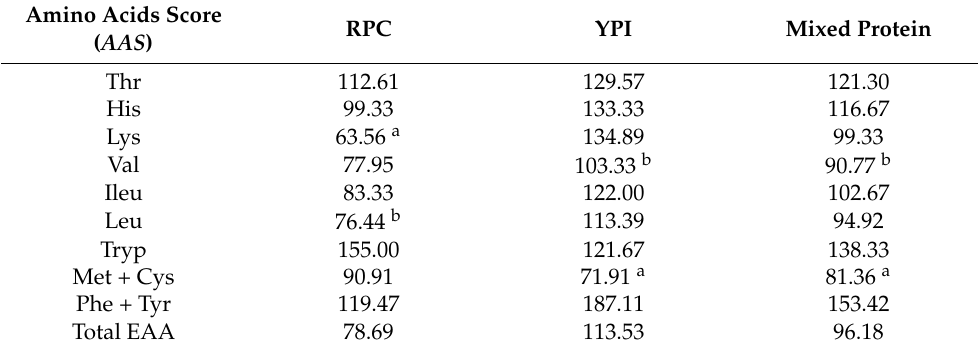
Table 6. Aminoacidscoresofthreedifferentproteinpowders. (a) AAS ofRPC,YPI,andmixed protein (50:50). Amino Acids